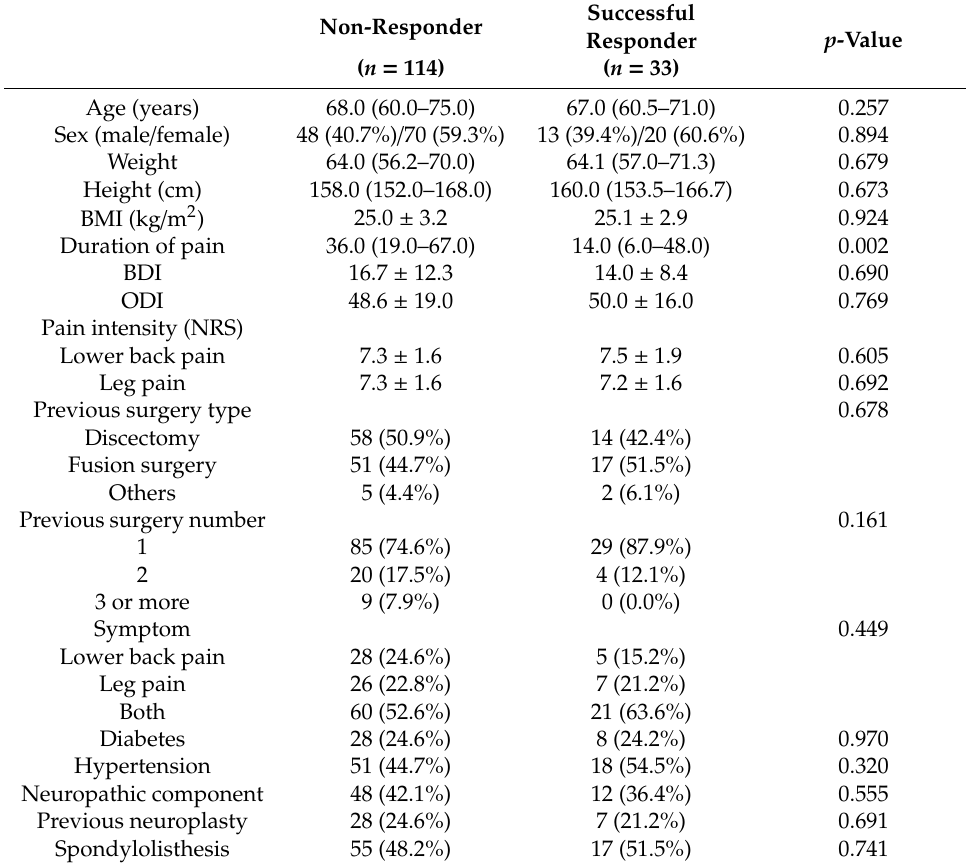
Table 3. Characteristics of the non-responders and responders at six months after combined epidural adhesiolysis and balloon decompression in patients with lumbar post-laminectomy syndrome.